Question: Briefly state, in one sentence, what is plotted here.
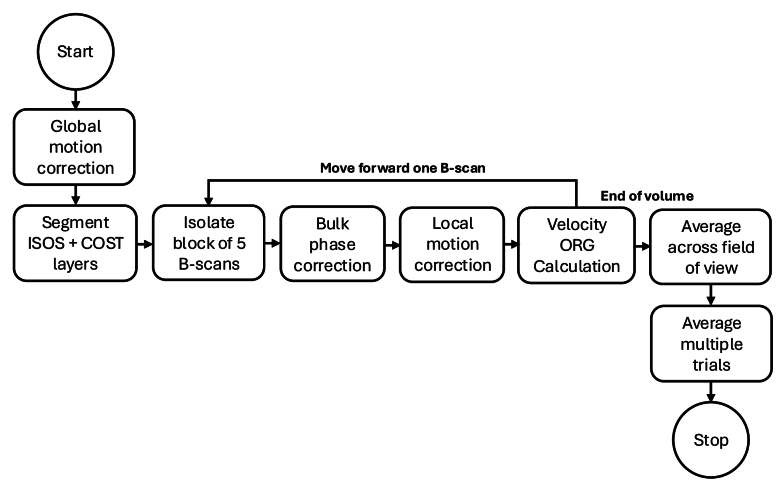
Answer: Data processing pipeline, featuring image registration, phase correction, and velocity ORG calculation.